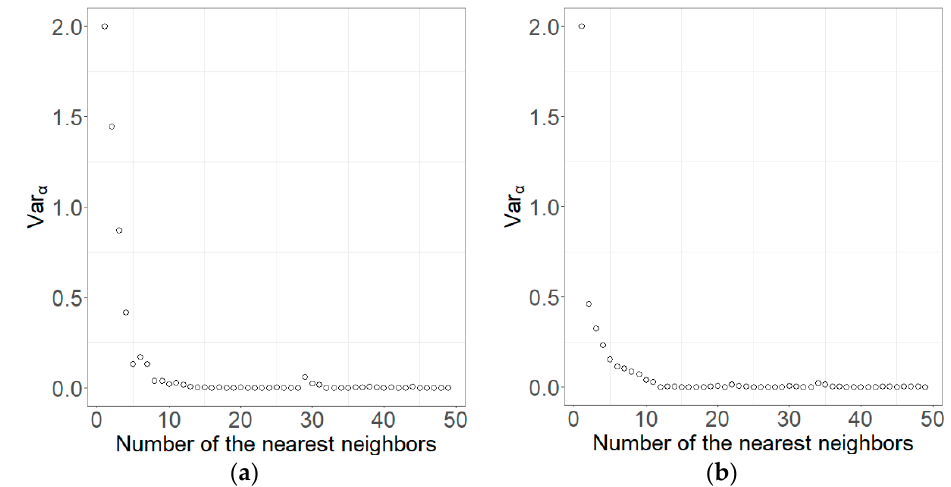
Figure 4. Variance change rates ( Var α ) against k (the number of nearest plots used) for two randomly selected locations (pixels ( a ) and ( b )) to be estimated in Duolun County.